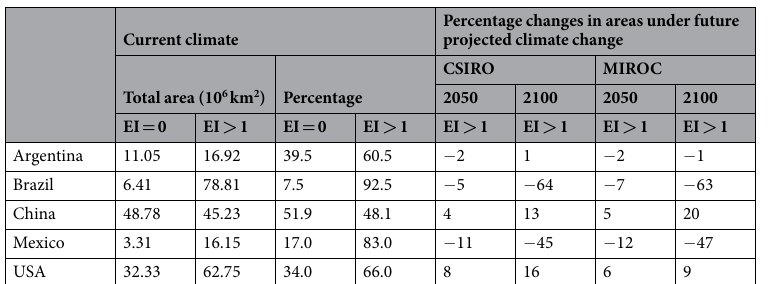
Current climate